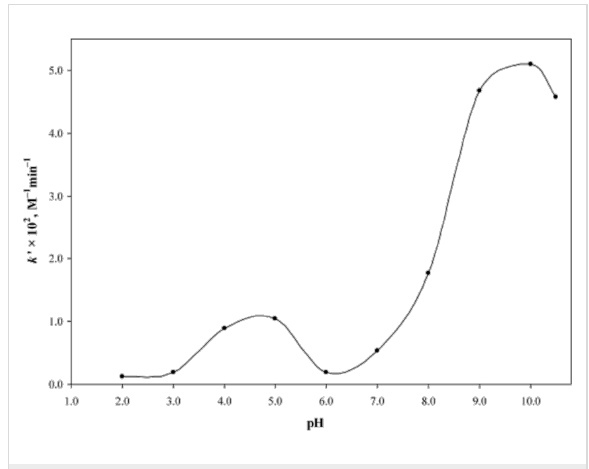
Figure 9: k' –pH profile for the photolysis of RF (5 × 10 − 5 M) in the presence of CF (0.5–2.5 × 10 − 4 M). Experimental conditions are the same as in Figure 6. Reproduced with permission from [29]. Copyright 2009 The Pharmaceutical Society of